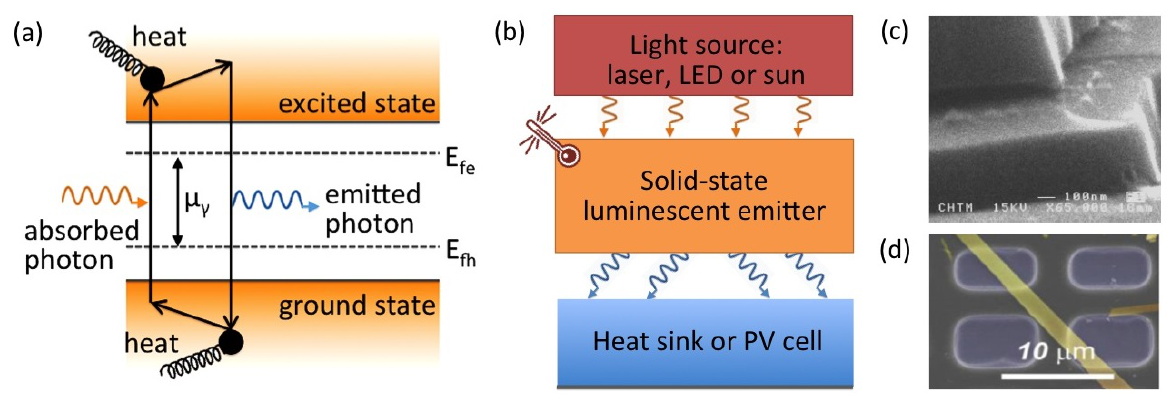
Fig. 9. Heat-assisted luminescence as a basis for optical refrigeration and photon up-conversion. (a) Energy diagram illustrating the pro- cess of the anti-Stokes luminescence under optical pumping. (b) Schematic of the energy exchange between an optical pump, a lumines- cent material exhibiting anti-Stokes luminescence, and a heat sink, which absorbs up-converted photons. (c, d) Demonstrated photonic so- lutions for enhancing the eflciency of laser cooling, including a high-index absorber optically coupled to the luminescent emitter through (c) a nanogap (reproduced with permission from [221], ©SPIE) (c), and (d) a nanobelt cryocooler (reproduced with permission from [222],